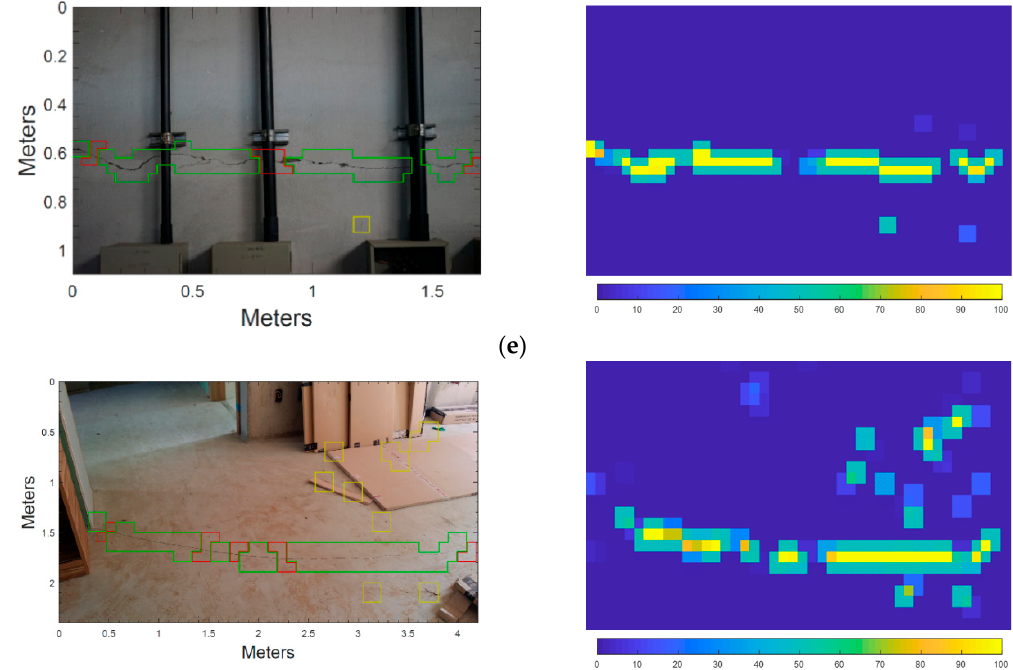
( f ) Figure 10. Crack detection result of each case by the proposed method (left column) and corresponding probability map (right column): ( a ) peeled concrete surface; ( b ) clean concrete surface; ( c ) concrete surface with many pores and construction joints; ( d ) dark concrete surface; ( e ) concrete surface with pipes and electric distribution boxes; and ( f ) floor with construction materials. Table 2. Crack detection result of six images in Figure